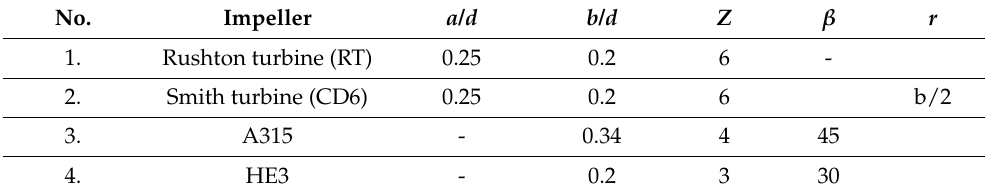
Figure 2. Located baffles inside vessel; ( a ) four planar standard baffles; ( b ) 24 vertical tubular baffles located on the circuit. Table 1. Geometrical parameters of